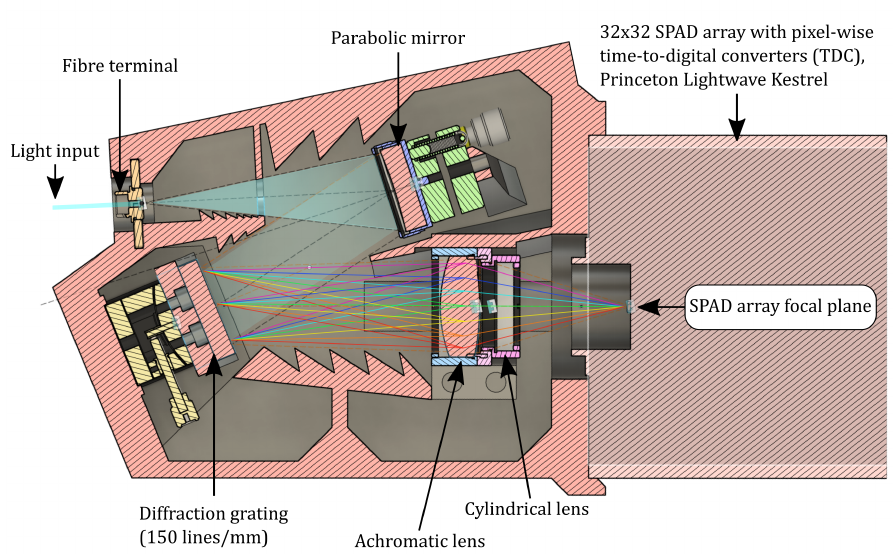
Figure 2. Cross-sectional view of the spectrograph assembly. The spectrally separated return pulse photons are passed through a cylindrical lens to distribute the wavelength bands along a single axis on the SPAD array, while the intensity information is recorded on the second axis.